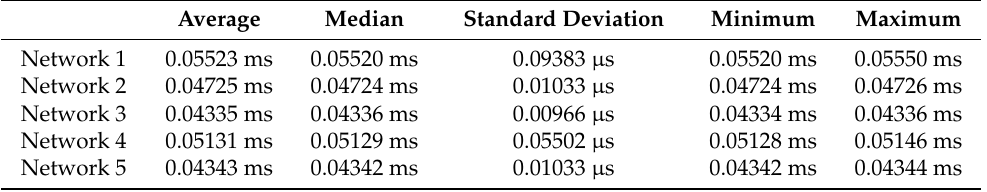
Table 4. Comparison between runtimes of each network for hardware implemented